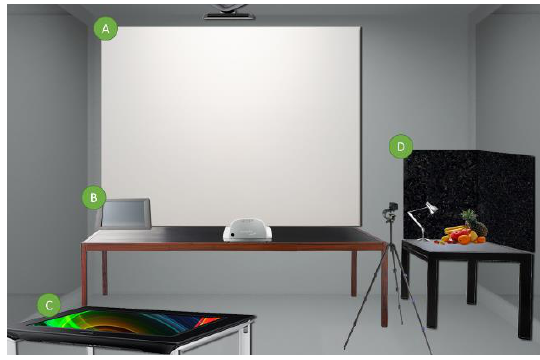
Figure 1. 3D design of the modern Art